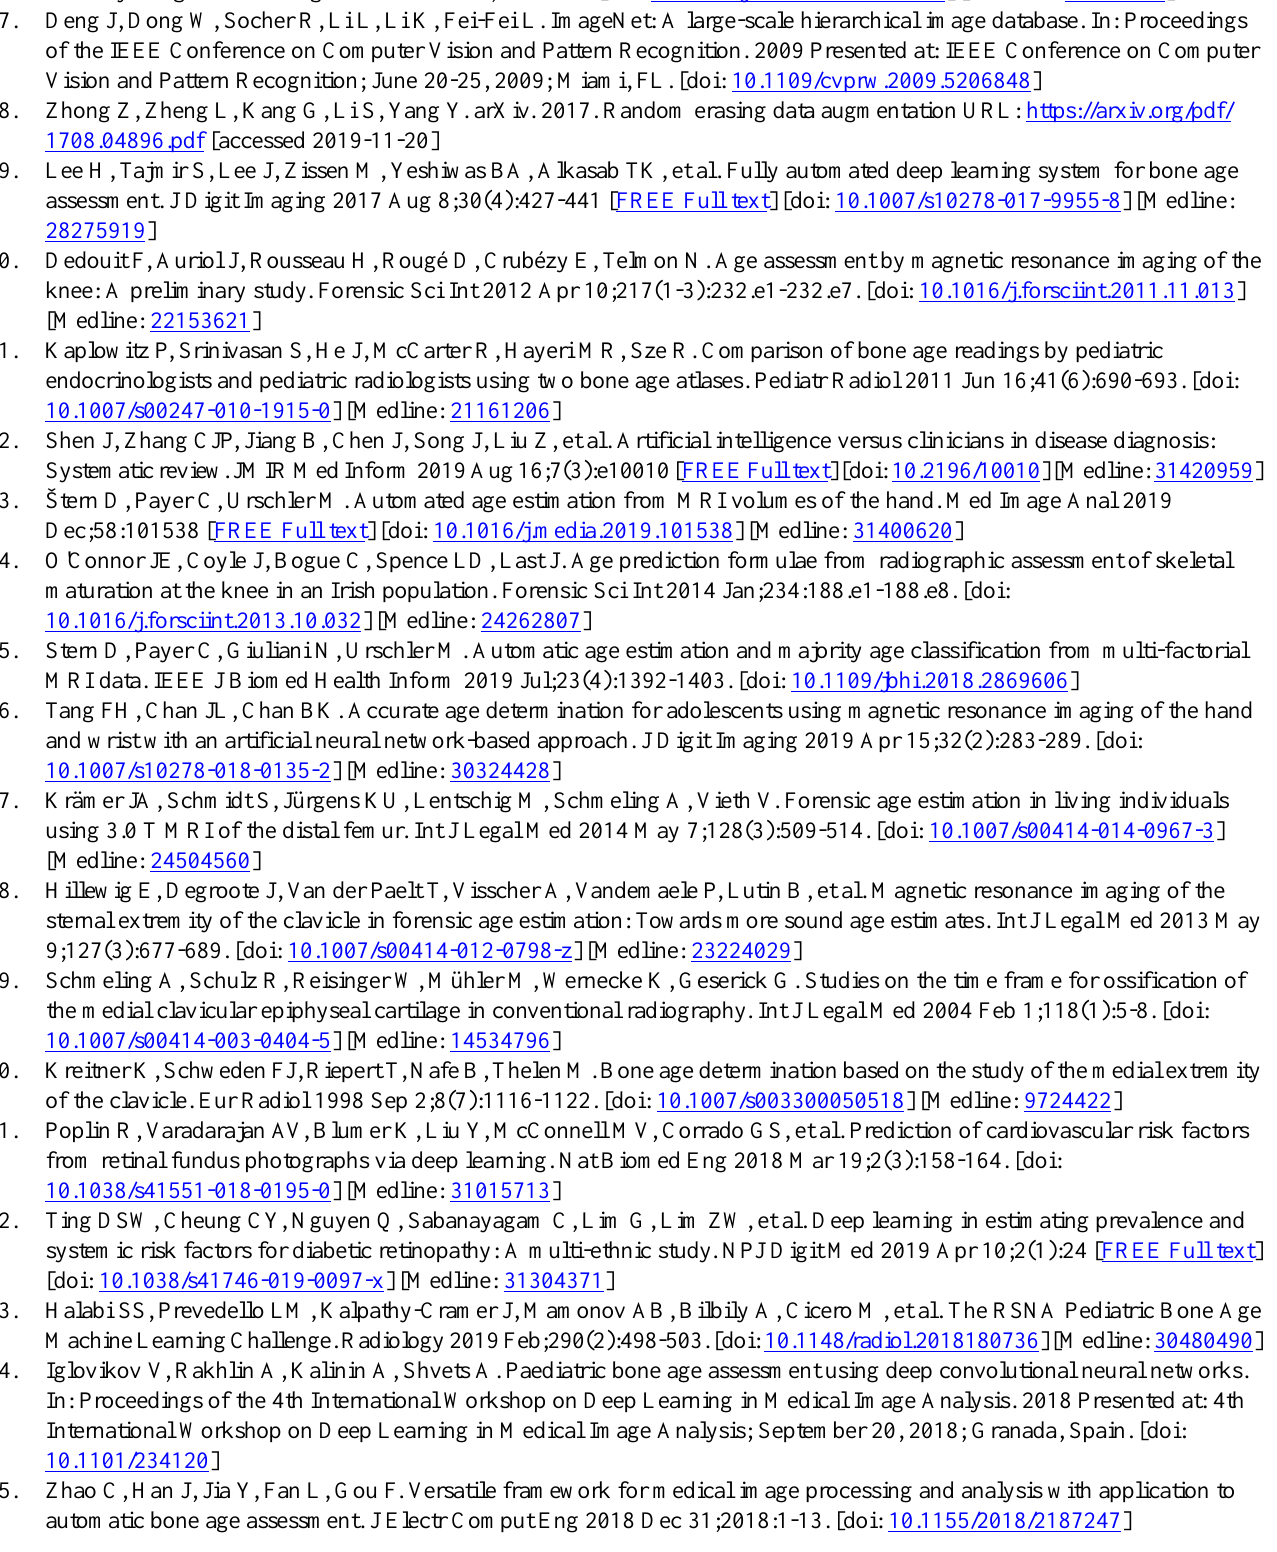
Abbreviations BAA: bone age assessment Caffe: Convolutional Architecture for Fast Feature Embedding CNN: convolutional neural